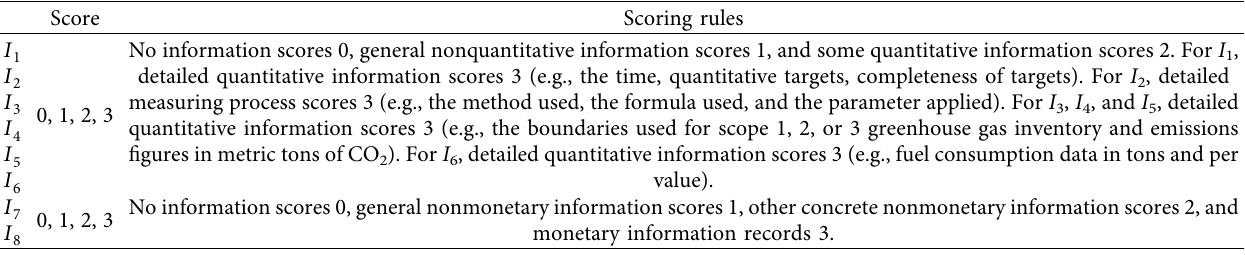
Table 3: Scoring rules of eight items of